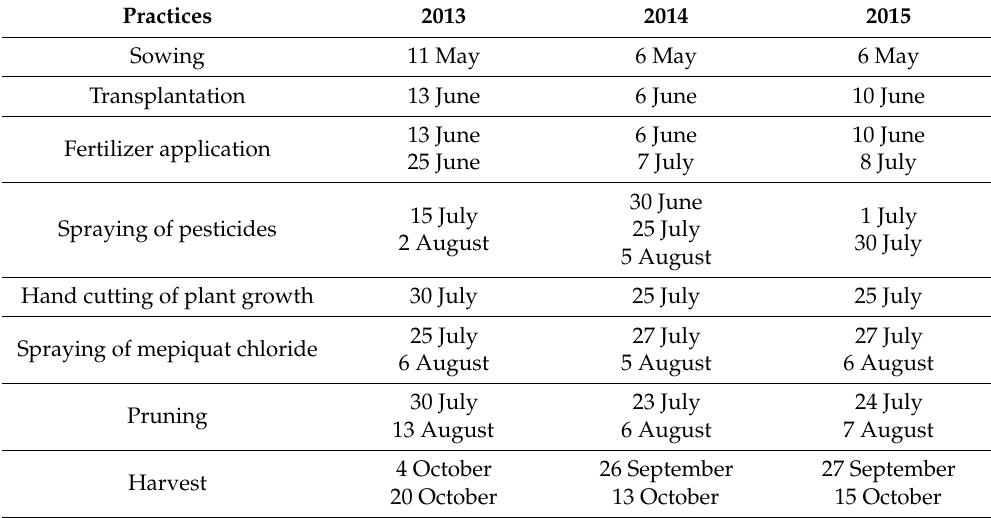
Table 2. Agronomic practices during the